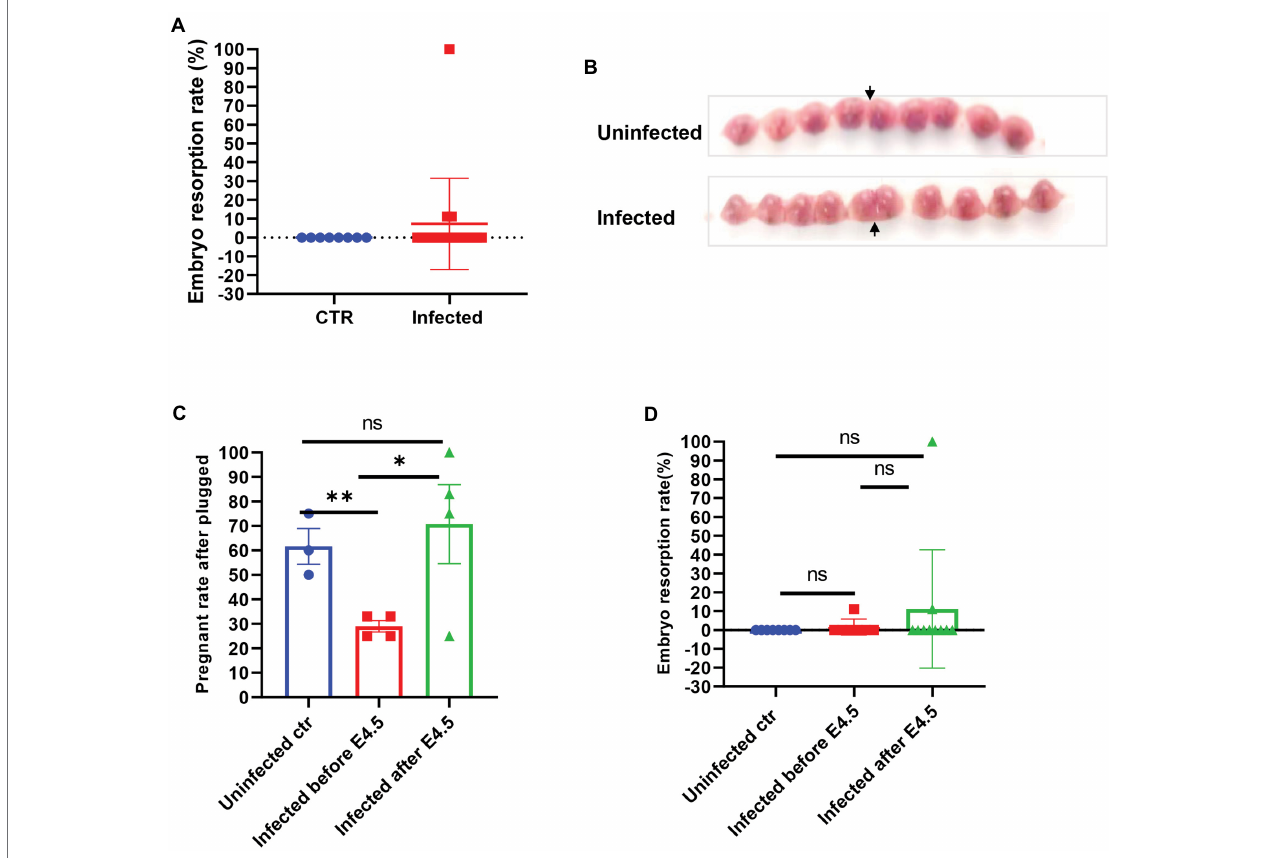
FIGURE 2 | The embryos of SARS-CoV-2 infection in pregnant mice. (A) Embryo resorption rates between and uninfected control (CTR, n = 8) and infected pregnant ( n = 17). (B) The typical graph of embryo development between uninfected (upper, E14.5) and infected (lower, E13.5). The site that the arrow pointed at was the uterine horn. (C) Further splitting the pregnant group into two groups by E4.5 (infected before E 4.5, n = 7 vs. infected after E 4.5 n = 10), the real pregnant rates after plugged (the numbers of pregnant mice/the numbers of plugged per experiment) were displayed. (D) Based on the prior group, the embryo resorption rates were compared. ns p > 0.05, * p < 0.05, and ** p <